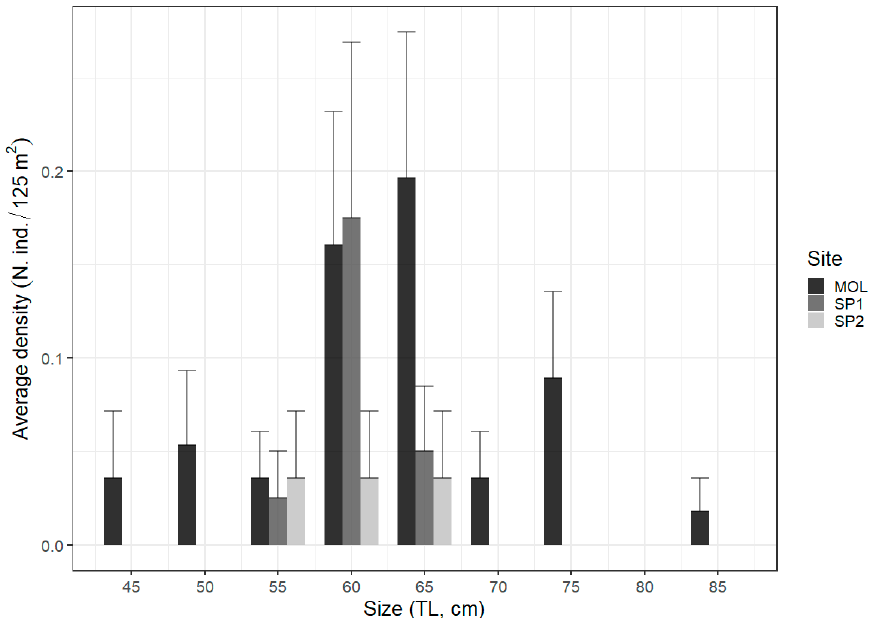
Figure 4. Mottled grouper average densities ( ± SE) recorded per strip transect (surface area 125 m 2 ) and size class (45–85 cm TL) at the three study sites in summer 2018.